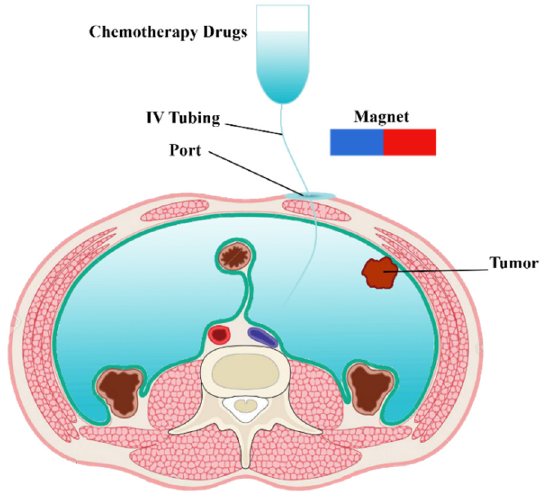
Figure 1. Schematic of a magnetically controlled IP drug targeting system.